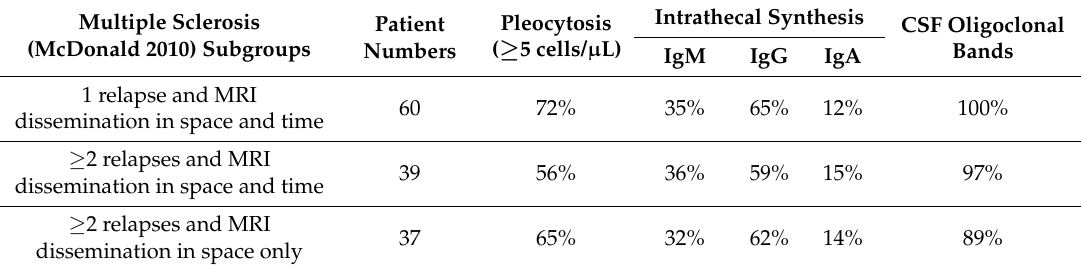
Table 4. Multiple sclerosis subgroups